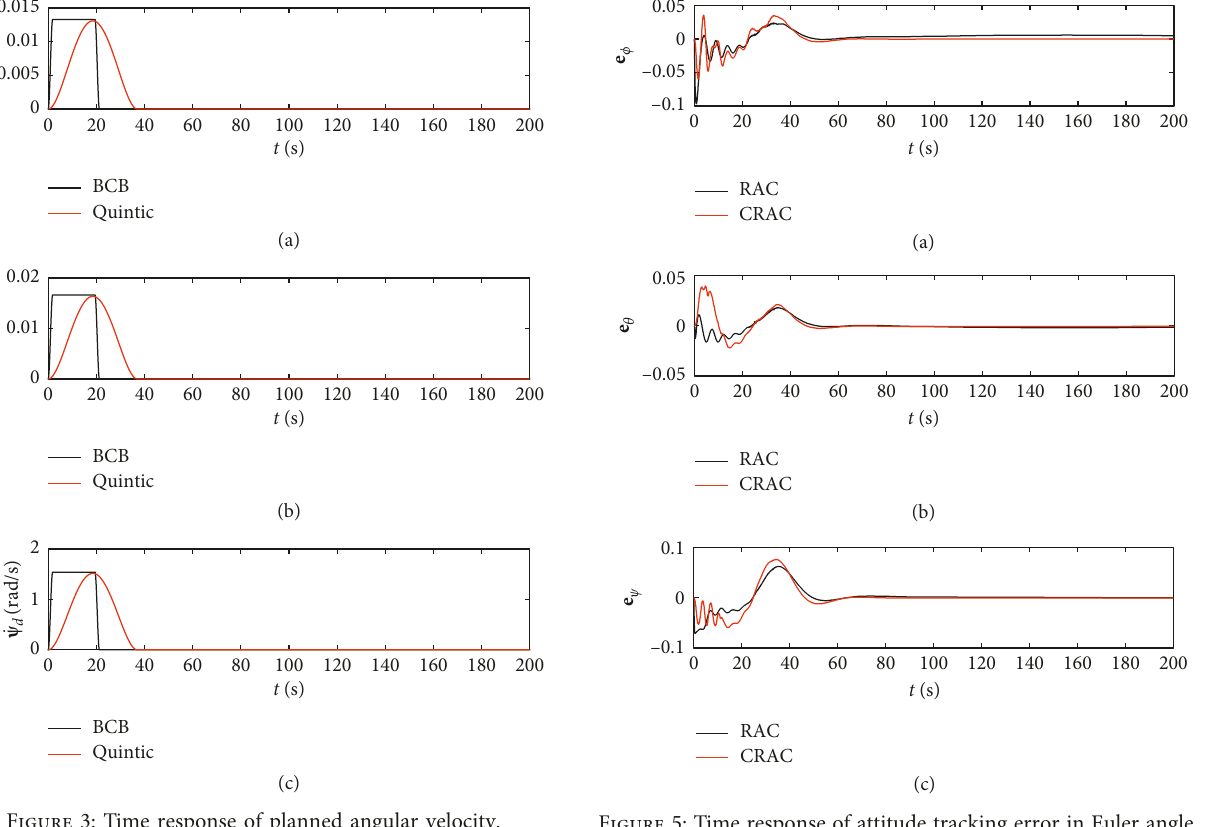
Figure 5: Time response of attitude tracking error in Euler angle.